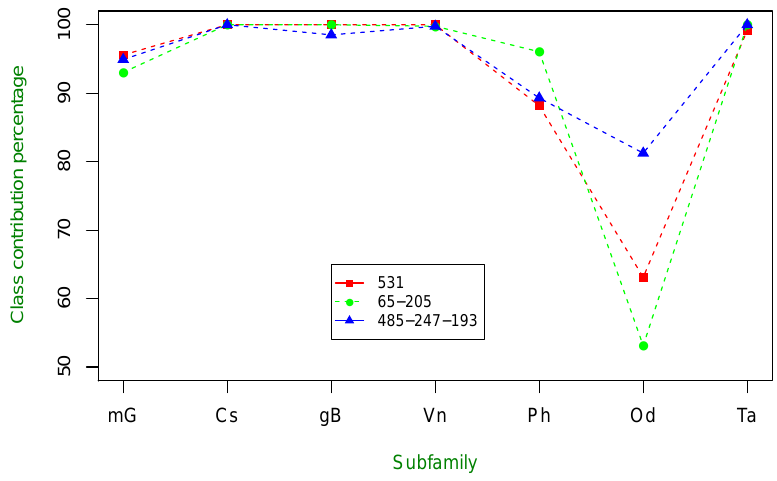
Figure 5. Class-specific percentage of contribution to overall classification using one, two and three amino acid property index combinations with the highest classification